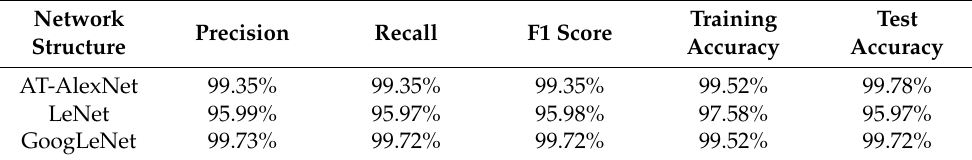
Table 7. The comparative experiment of corn disease detection networks.